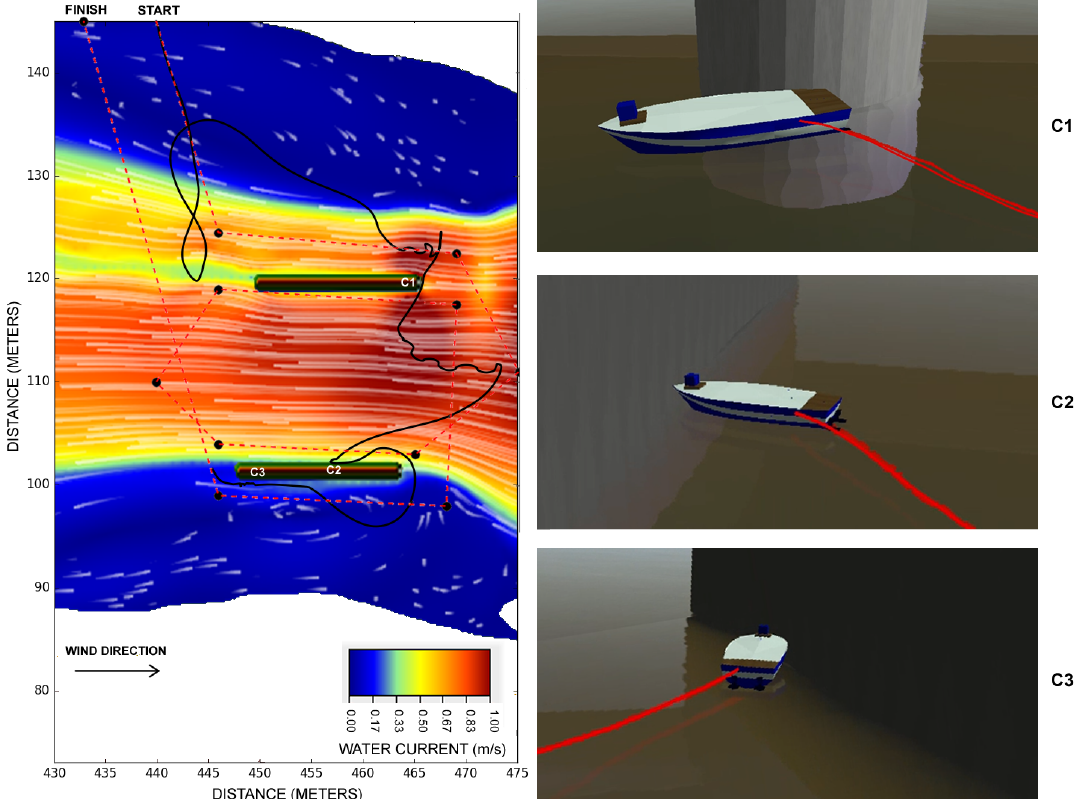
Figure 12. Bridge inspection scenario with differential